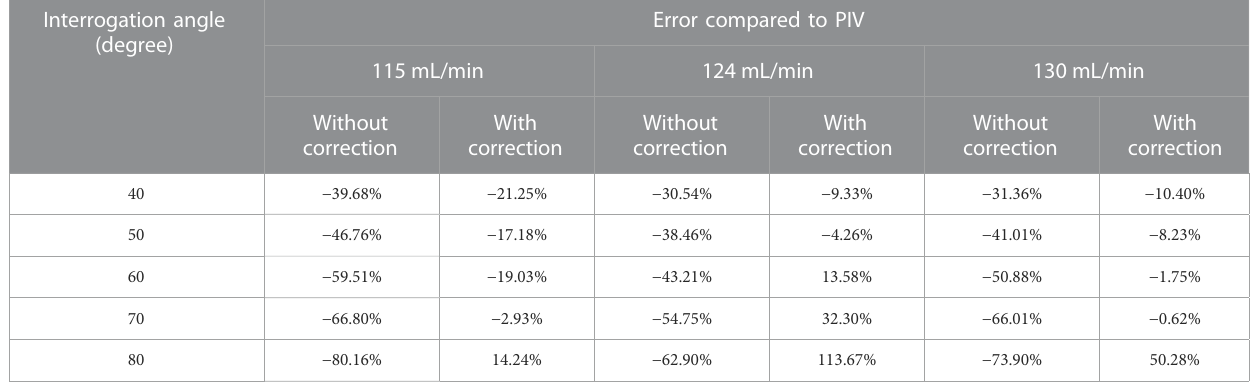
TABLE 3 Velocity measurement error compared with PIV values on several interrogation angles. Interrogation angle (degree)